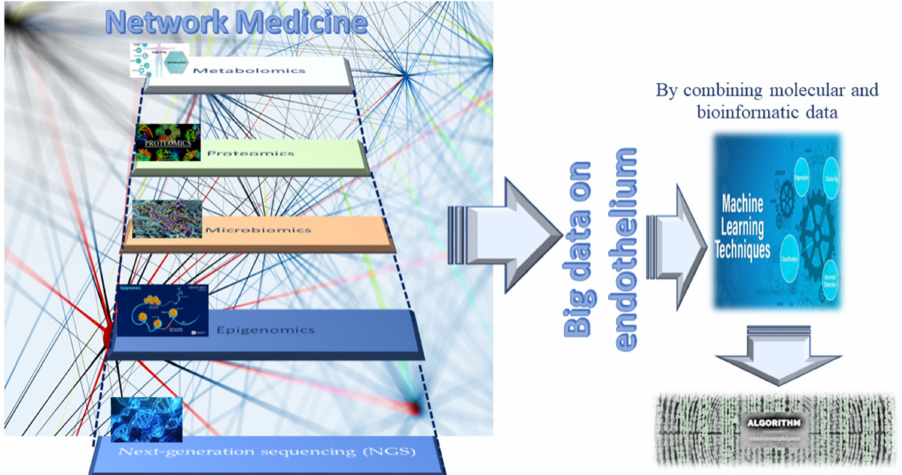
Figure 4. Network medicine and its features in endothelium